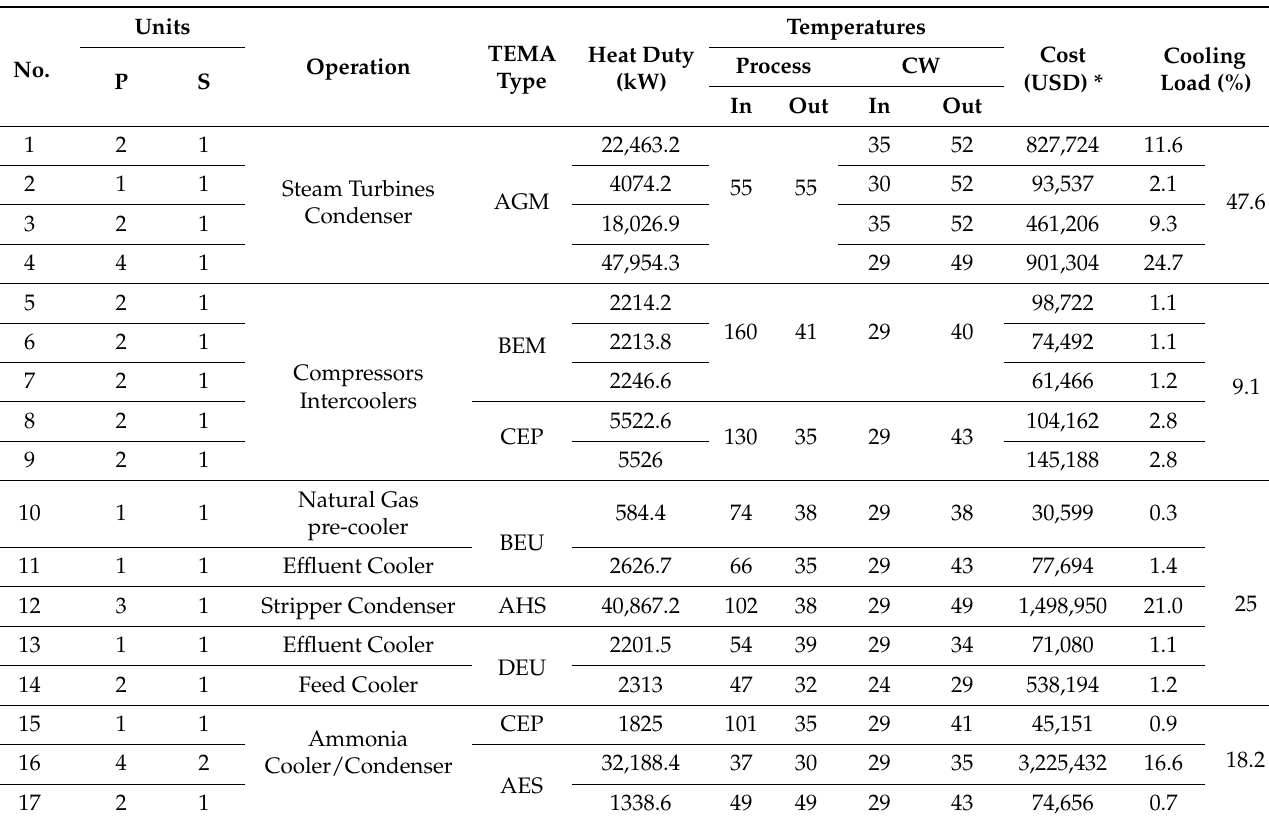
Table 1. Major shell and tube heat exchanger coolers employed the ammonia production process. * Cost was evaluated by simulating existing heat exchangers using the economics feature in ASPEN EDR v